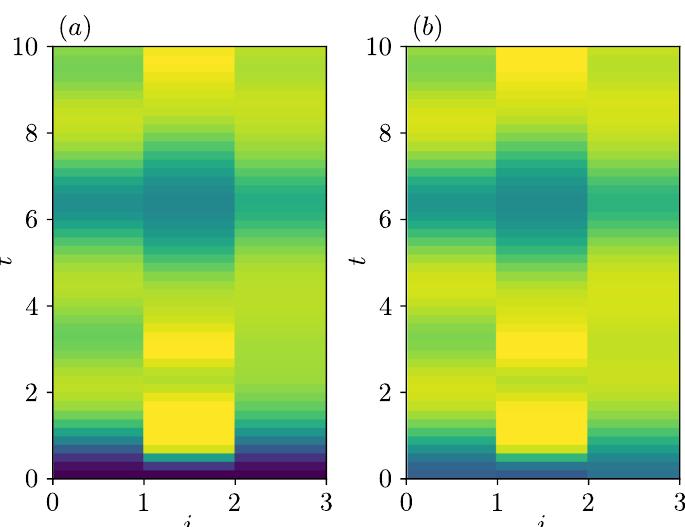
Figure 14: The OTOC C ( i , t ) at short distances, original data (a) and short term (cid:80) k = 4 C l ( i , t ) (b). Apart from the initial growth, all features are well contributions l = 1 captured by the contributions of the shortest